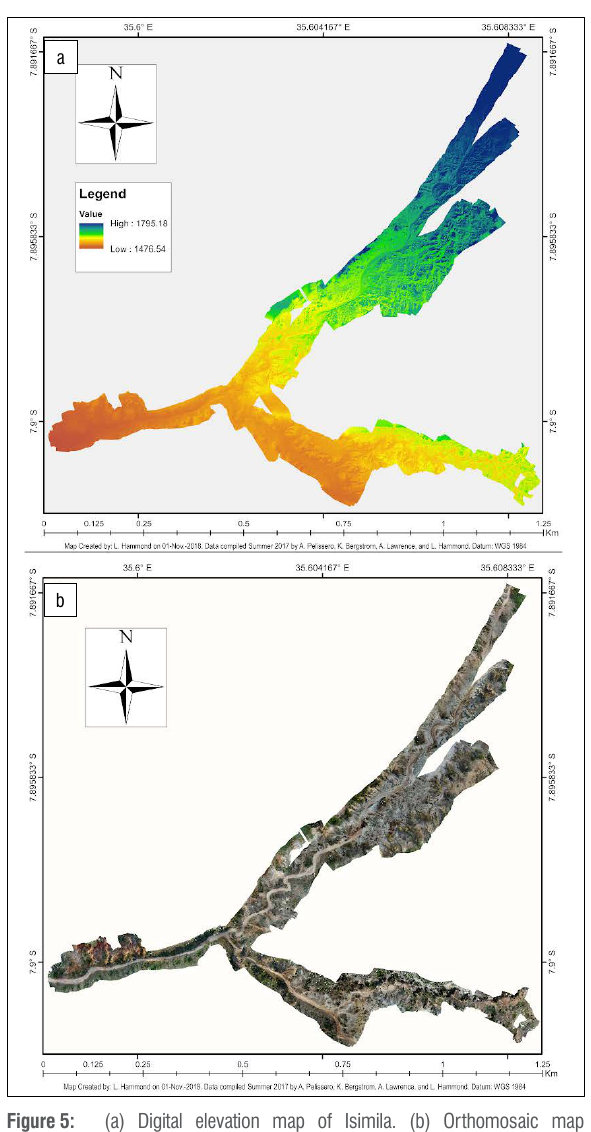
Figure 5: (a) Digital elevation map of Isimila. (b) Orthomosaic map of Isimila.